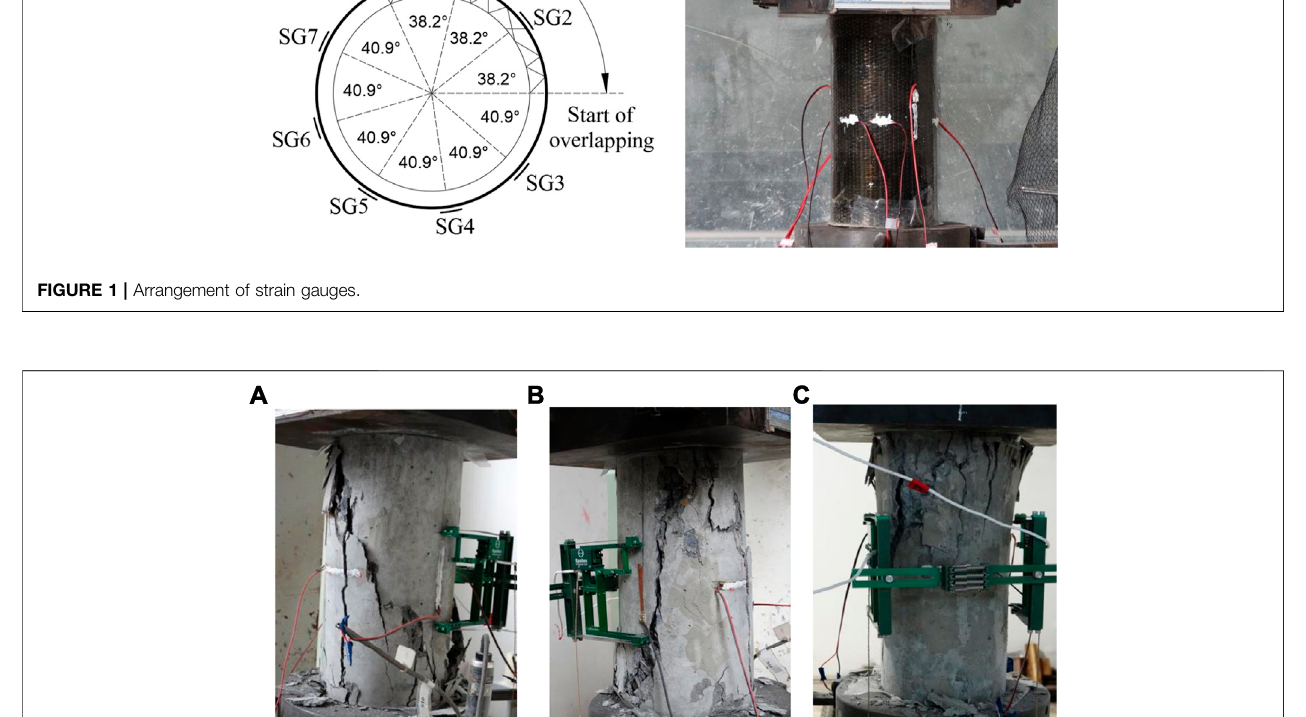
Frontiers in Materials |